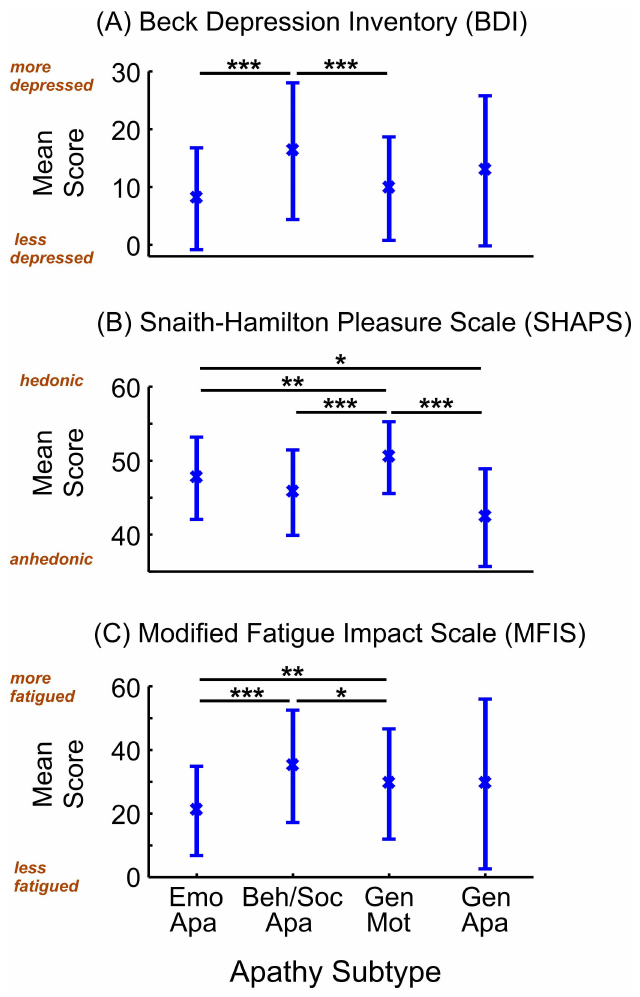
Fig 4. Relationships between apathy subtype and depression, anhedonia and fatigue. The four apathy- motivationsubtypeswere predictive of different associations with depression (A), anhedonia(B) and fatigue (C). The behaviourally/sociallyapathetic experienced the greatest depression and fatigue whilethe generally motivated were most hedonic.( * p < 0.05, ** p < 0.01, *** p < 0.001).